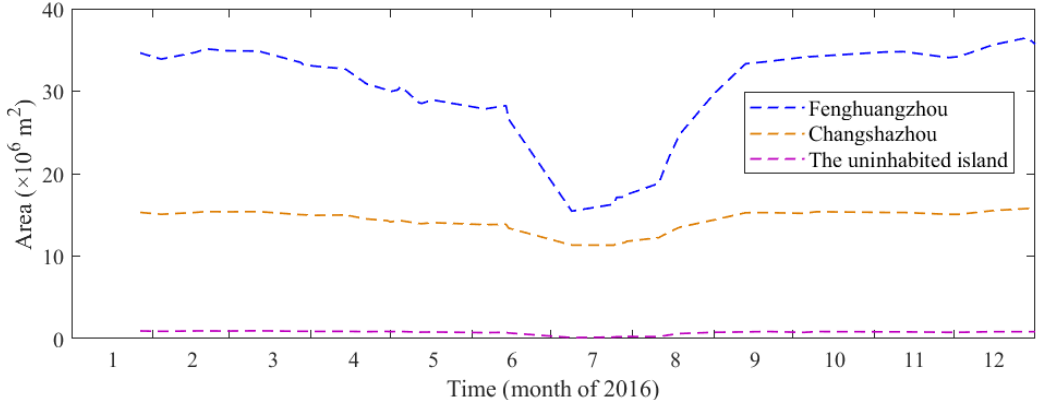
Figure 3. River islands change with the water level.